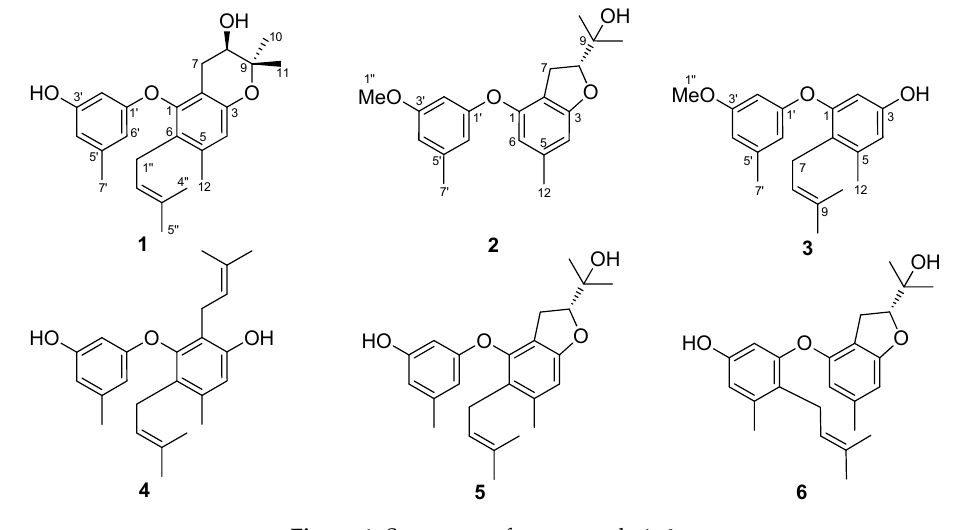
Figure 1. Structures of compounds 1 – 6.